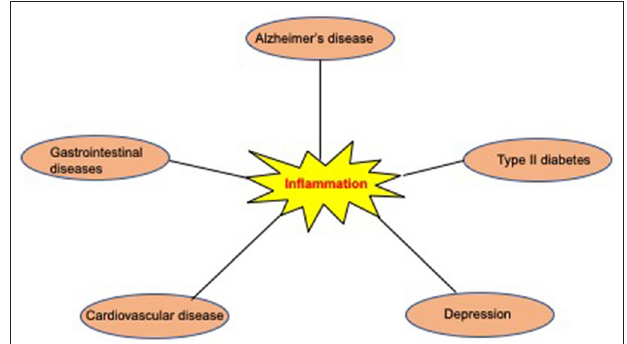
FIGURE 1 | Most common comorbidities associated with AD. Evidence from epidemiological and molecular studies suggest that several conditions including type 2 diabetes, cardiovascular diseases, depression, and gastrointestinal diseases may be associated with an increased risk for AD. Inflammation may be a central mechanism underlying the association between AD and most of its comorbidities.